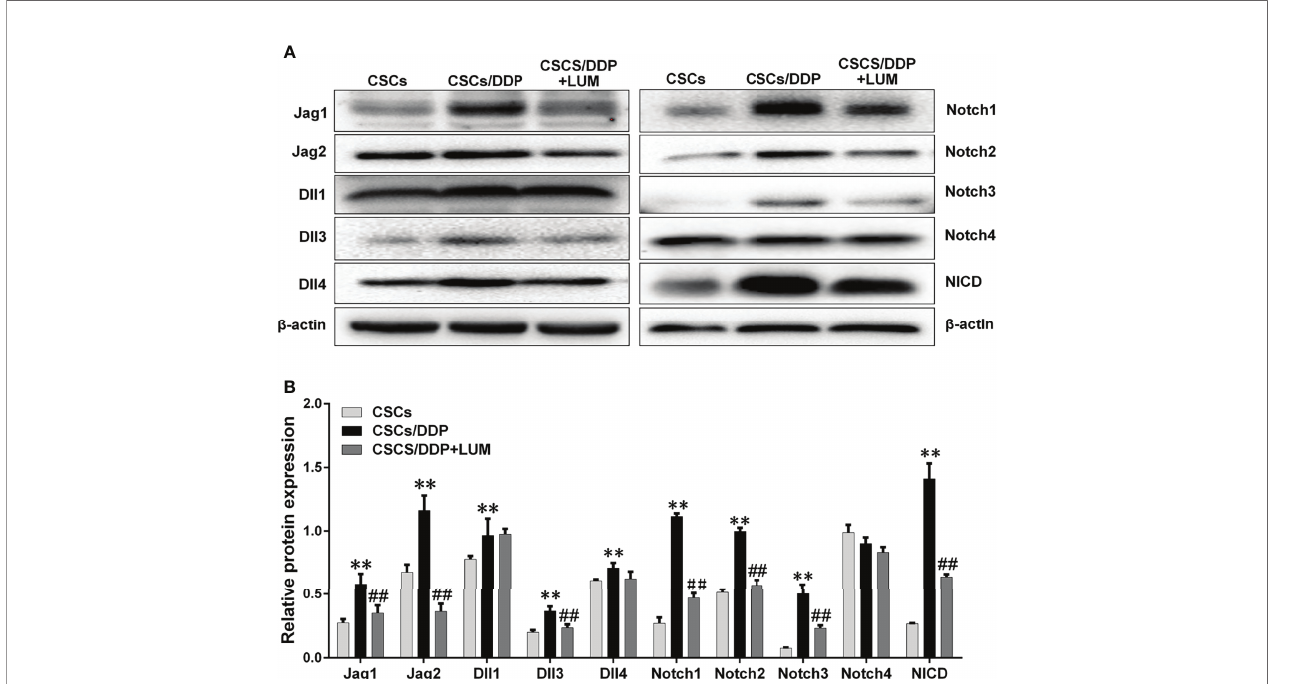
FIGURE 6 | Lumi fl avin downregulated the protein expression of Notch signaling pathway in DDP-resistant cancer stem cells (CSCs/DDP). CSCs, CSCs/DDP were treated with 80 m M DDP, and CSCs/DDP were treated with 80 m M DDP and 80 m M lumi fl avin for 72 h. The expression levels of Jag1, Jag2, Dll1, Dll3, Dll4, Notch1, Notch2, Notch3, Notch4, NICD, and b -actin were analyzed via Western blot by using speci fi c antibodies. (A) Electrophoretograms of proteins. (B) Graph of relative protein expression as determined by Western blot analysis. ** P < 0.01 compared with CSC group; ## P < 0.01 compared with CSCs/DDP group. Mean ± SD ( n = 5). CSCs, CSCs were separated from OVCAR-3 cells line; CSCs/DDP, CSCs were separated from OVCAR-3/DDP cells line; LUM, lumi fl